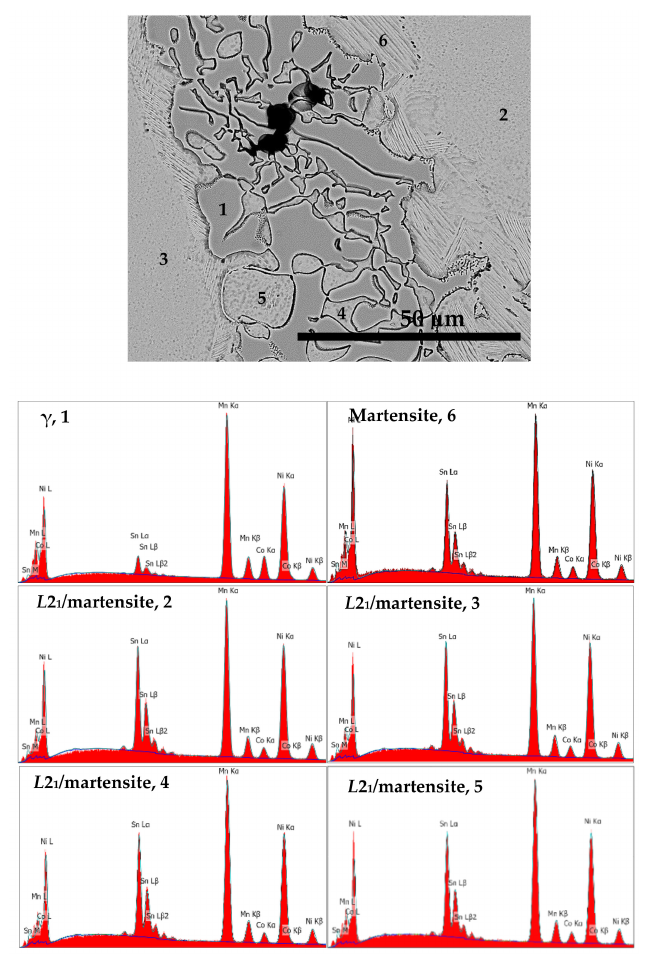
Figure 9. BSE micrograph and EDS spectra of di ff erent regions seen in